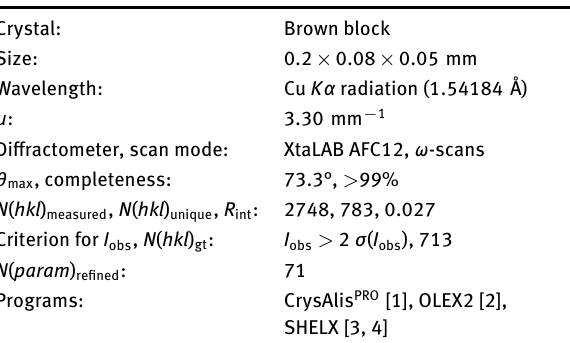
Table 1: Data collection and handling.